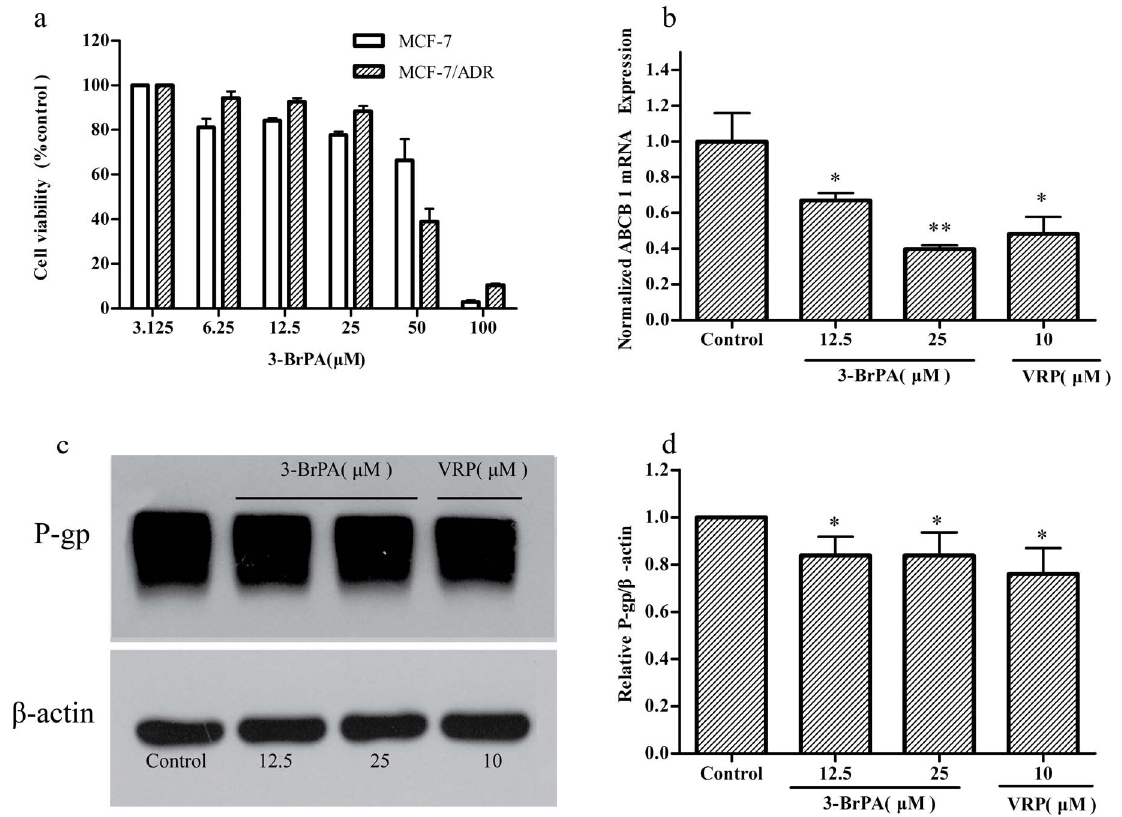
Figure 3. The cytotoxicity of 3-BrPA, effect of 3-BrPA on the mRNA and protein expression levels of ABCB-1/P-gp . These cell lines were exposed to the indicated concentration of 3-BrPA for 48 h, and cell viability was determined by MTT assay. Each points represents the mean 6 SD (n=6). Each experiment was performed three times. a: The cytotoxicity of 3-BrPA in MCF-7, MCF-7/ADR,After treated with desired concentrations of 3- BrPA for 48 h b: The mRNA level of P-gp in MCF-7/ADR cells treated with or without 3-BrPA was determined by real –time PCR, b -actin served as internal controls for real-time PCR respectively. c, d: The protein expression level of P-gp in MCF-7/ADR cells treated with or without 3-BrPA was determined by Western blotting analysis, b -actin served as internal controls Western blotting, respectively. * P , 0.05 compared with the control, ** P , 0.01compared with the control.